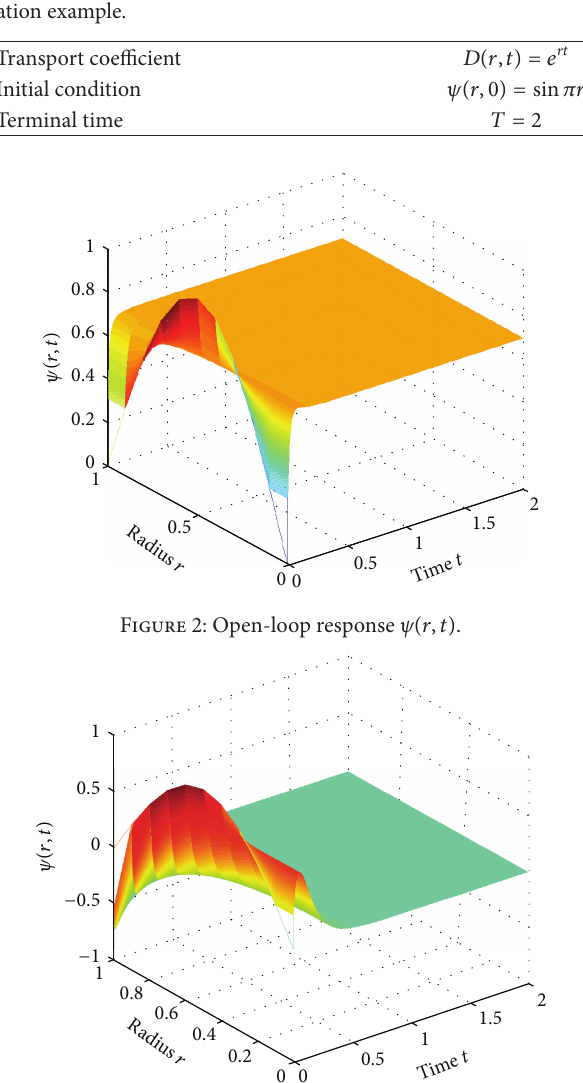
Figure 3: Closed-loop response 𝜓(𝑥,𝑡) corresponding to the opti- mal controller 𝑢 ∗ (𝑡)